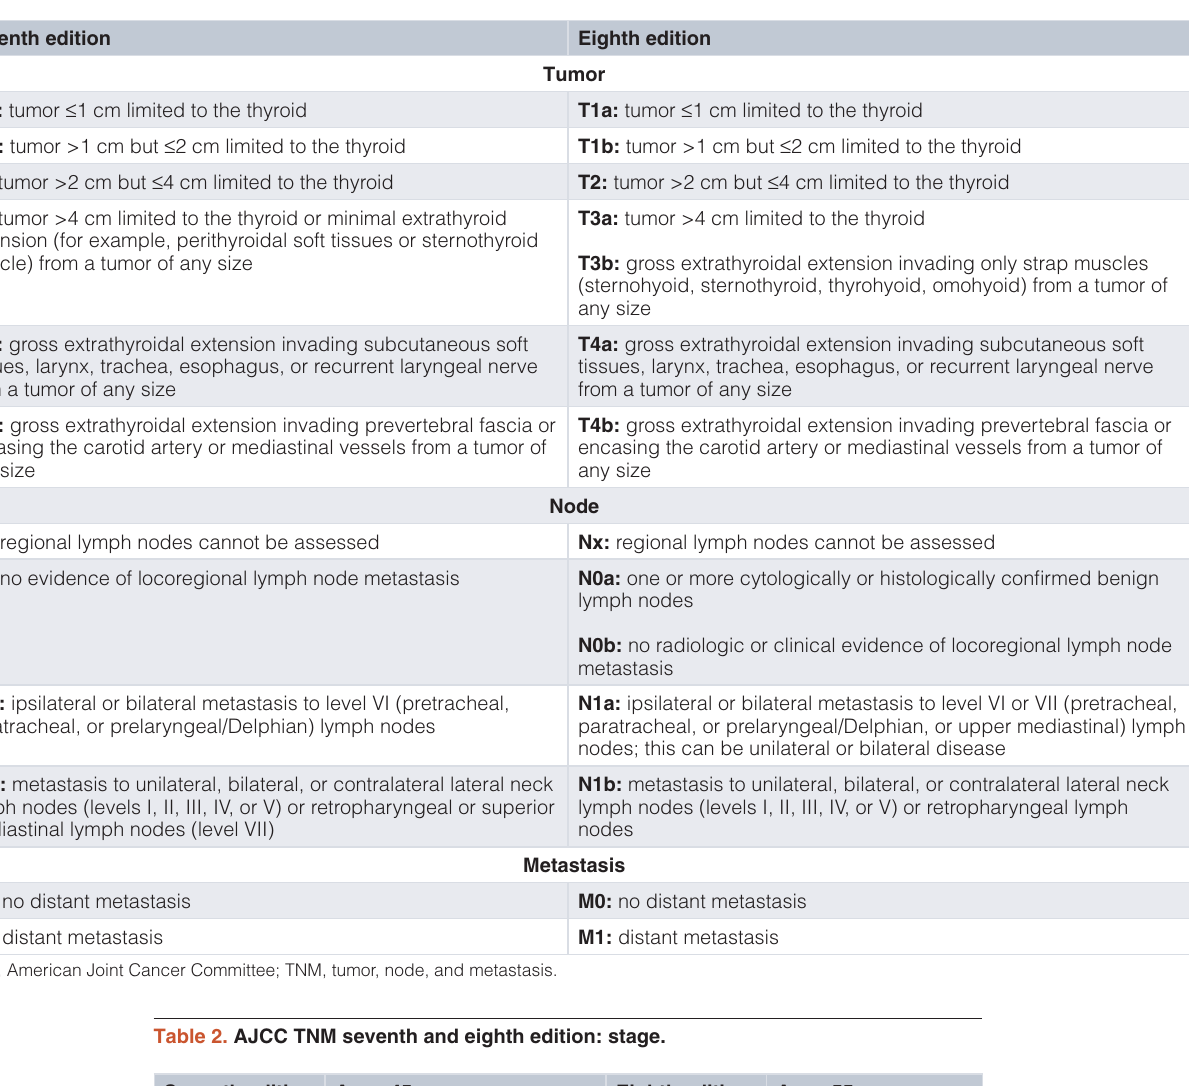
Table 1. AJCC TNM seventh and eighth edition: